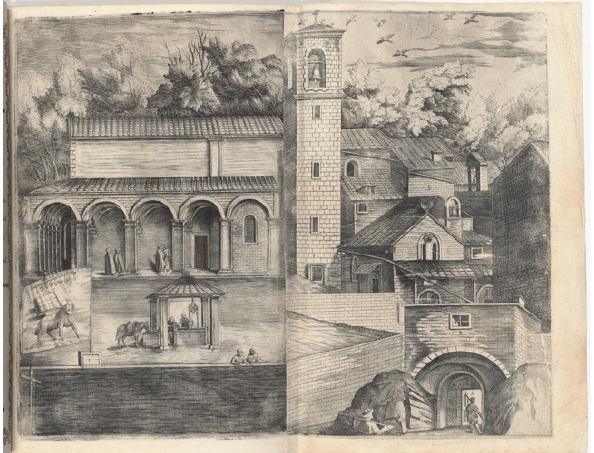
Figure 7. Jacopo Ligozzi, Chiesa Maggiore, plate D, engraving from Lino Moroni’s Descrizione del Sacro Monte dell Vernia , 1612 (photo source: Courtesy National Gallery of Art, Washington).